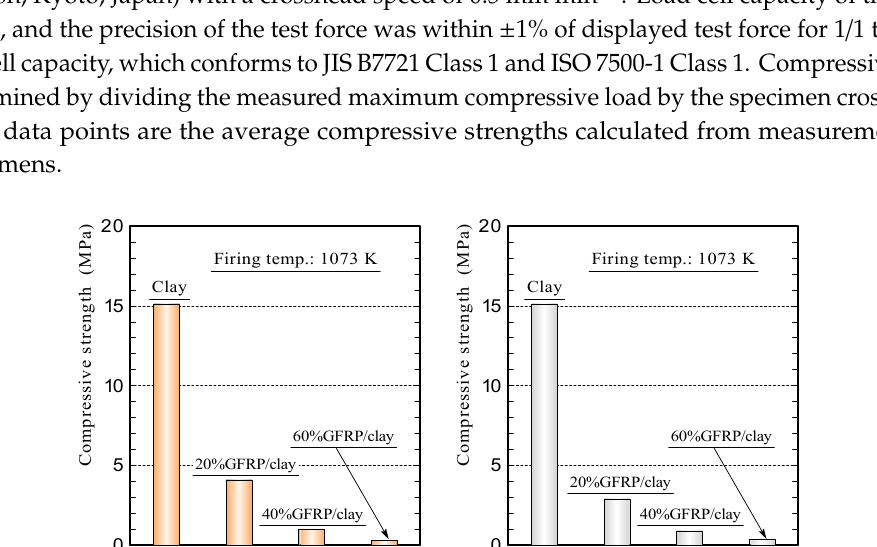
Figure 4. The compressive strength of the GFRP/clay ceramics.